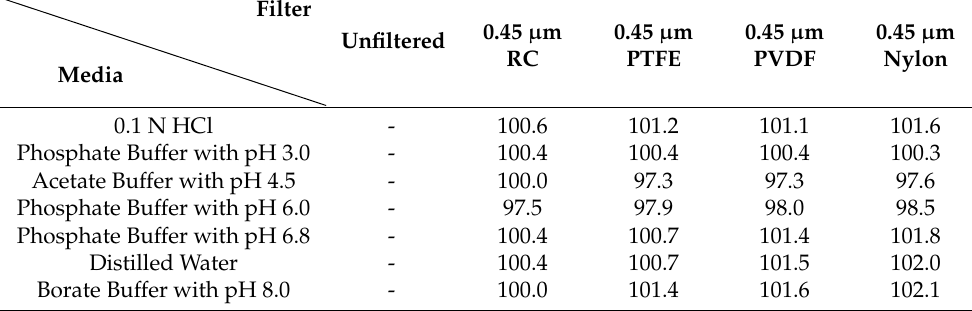
Table 1. Filter Selection: Area Similarity% Results for Favipiravir Standard Solution.